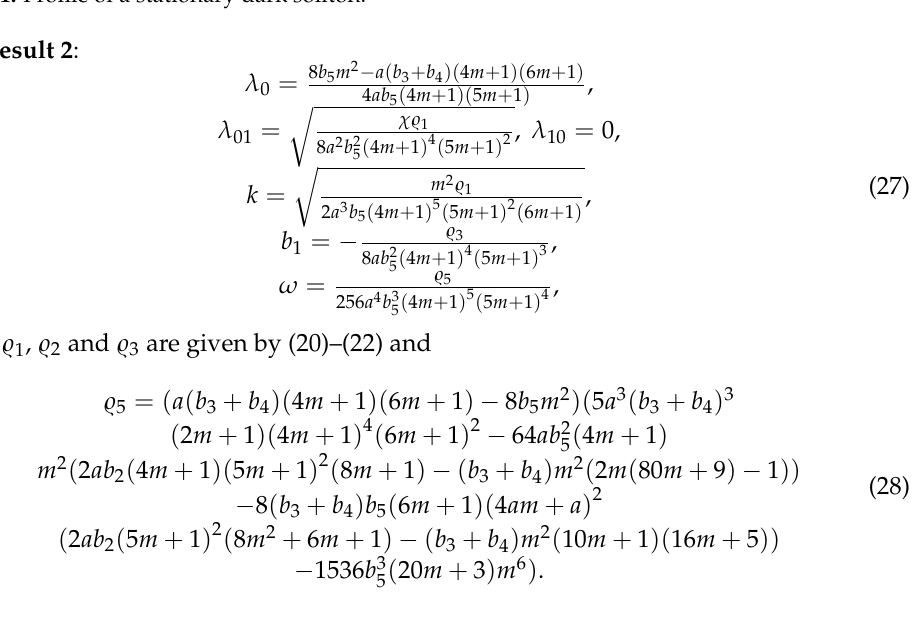
Figure 1. Profile of a stationary dark